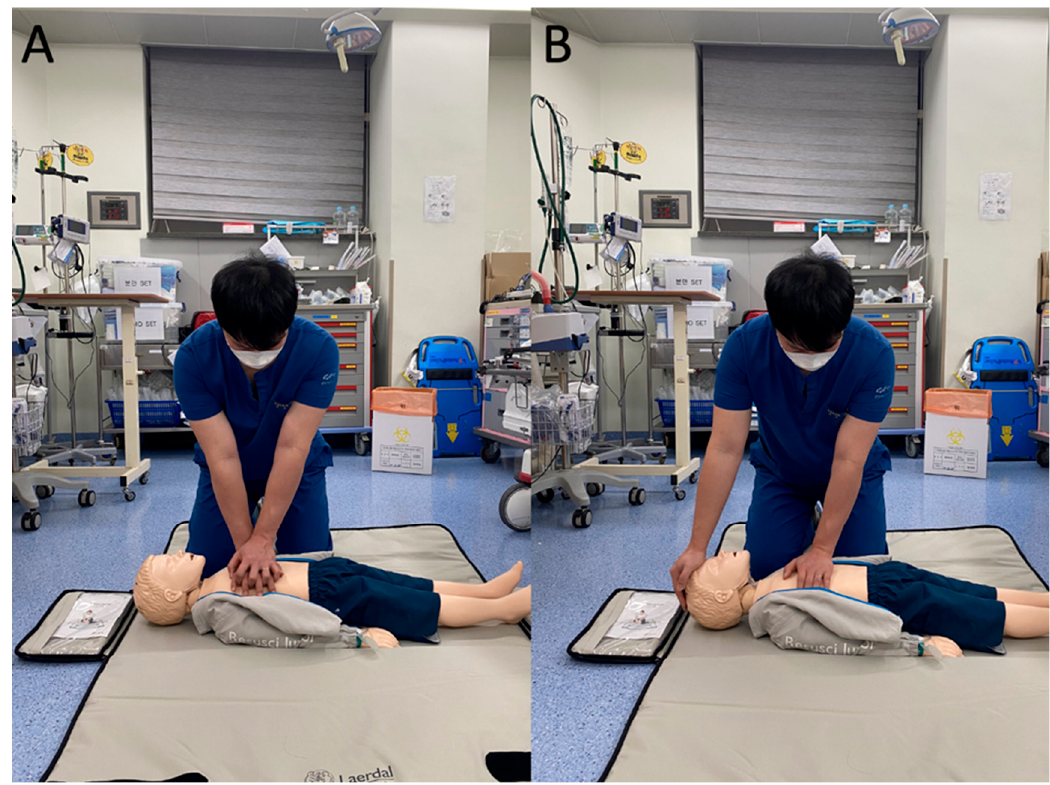
Figure 1. Two different chest-compression techniques recommended for pediatric cardiopulmonary resuscitation. ( A ) Two-handed chest compression; ( B ) one-handed chest compression.